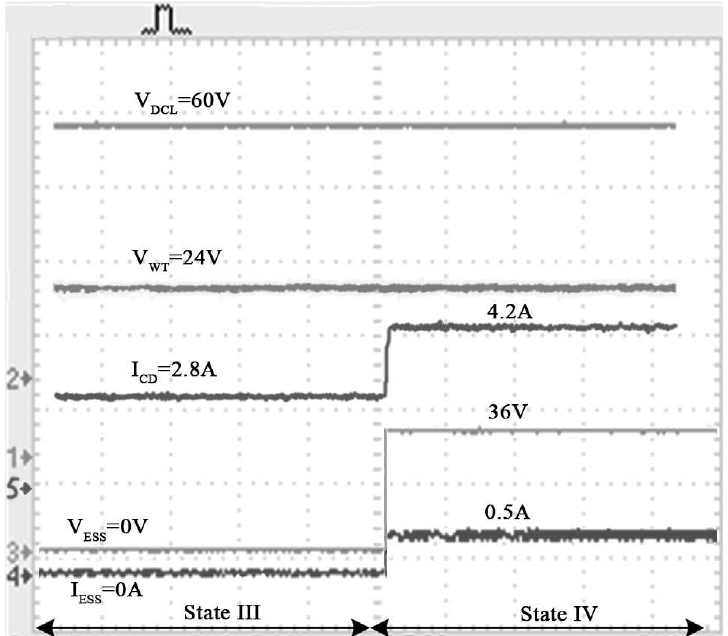
Figure 29. Experimental result for states III and